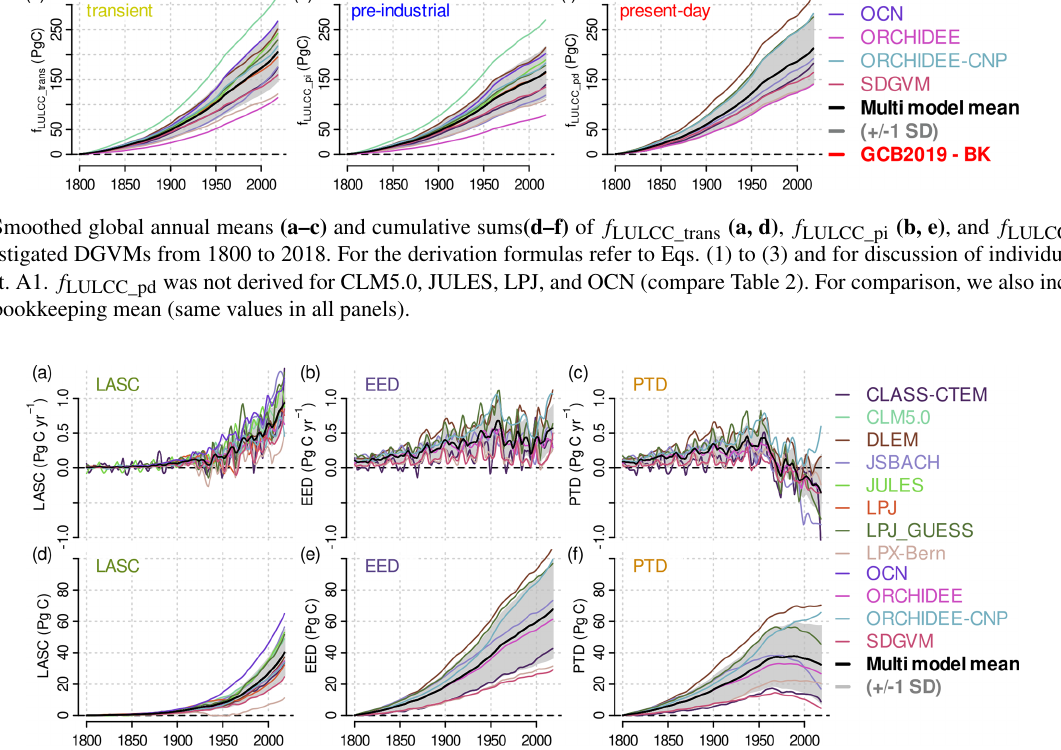
Figure 4. Smoothed global annual values (a–c) and their cumulative sums (d–f) of the differences in f LULCC estimates for the investigated DGVMs from 1800 to 2018: loss of additional sink capacity (LASC; a, d ), environmental equilibrium difference (EED; b, e ), and “present- day” vs. “transient” environmental conditions difference in the f LULCC (PTD; c, f ). For the derivation formulas refer to Eqs. (4) to (6) and for discussion of individual models refer to Sect. A1. The EED and PTD were not derived for CLM5.0, JULES, LPJ, and OCN (compare Table